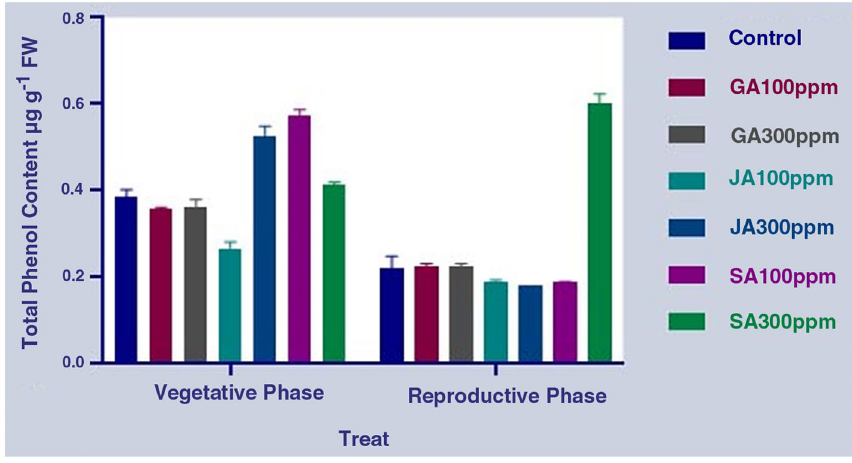
Figure 5. Diagram for comparing the effect of different hormonal treatments on the total phenol content in the aerial part at different phenological stages of S. striata .